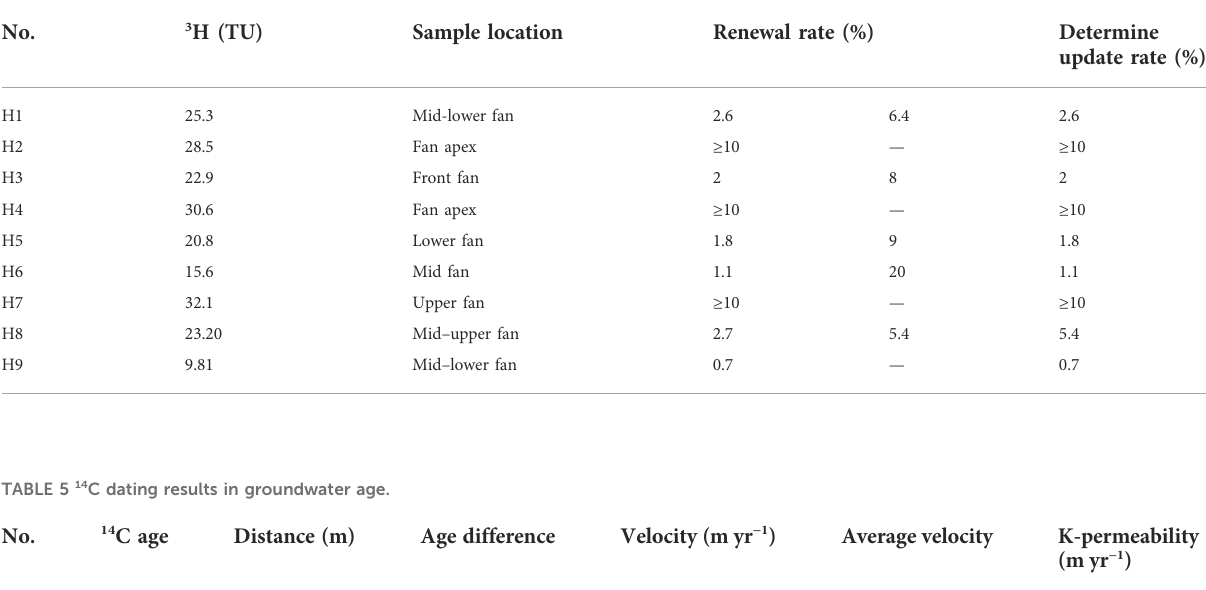
TABLE 4 Renewal rate of shallow groundwater in the Beijing Plain.